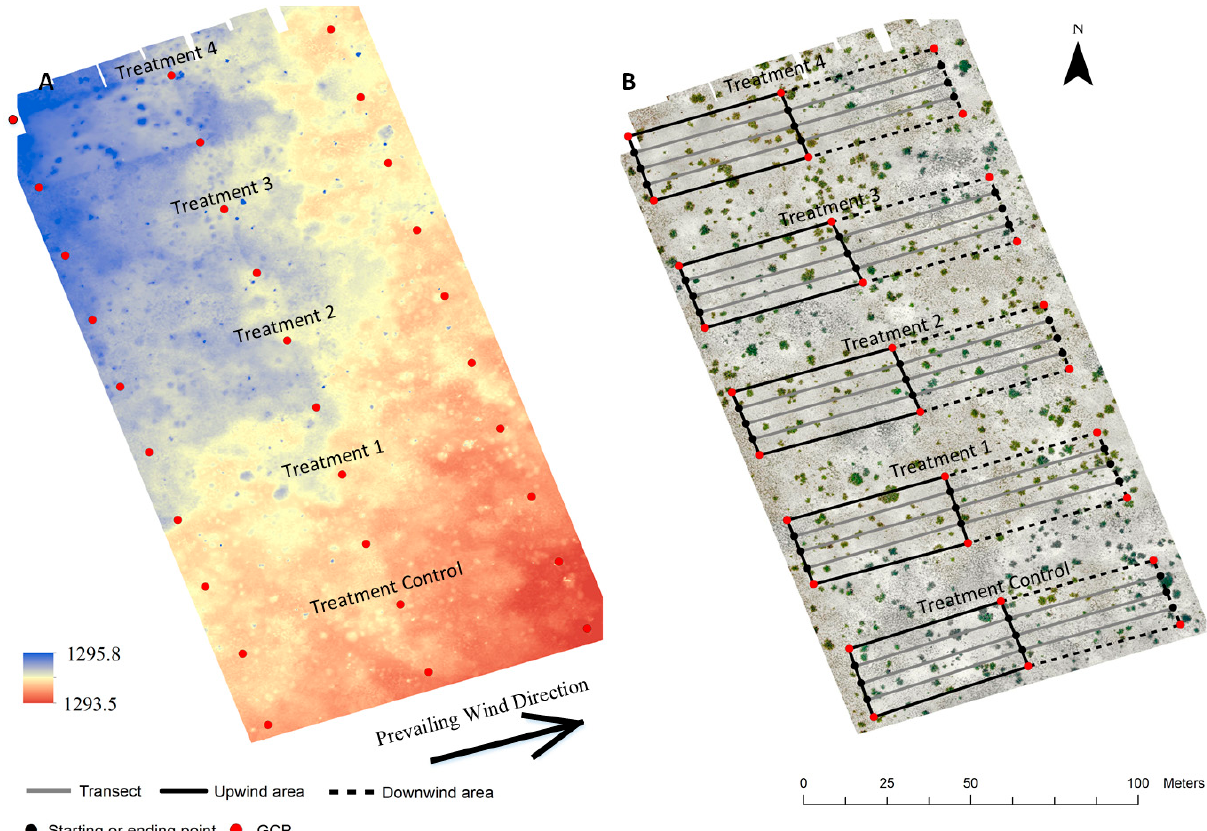
Figure 2. The digital surface model (DSM) and orthomosaics ( A , B ) [6] of Block 3 based on the structure from motion (SfM) models. The images were produced by using photos taken in the summer of 2017 using a Dà-Ji ā ng Innovations (DJI) camera.